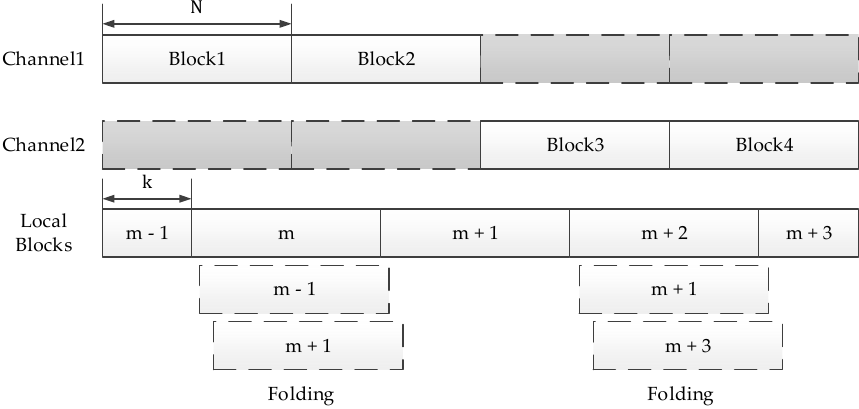
Figure 2. Input blocks and local blocks, each with length N. Local channel 1 is composed of Block 1 and Block 2, channel 2 is 3 and 4. The offset between input block and local block is k, k is uniformly distributed in [1, N]. Block m − 1 to block m + 3 are added together term by term to produce a new block. And the new block is zero padded to 2N.